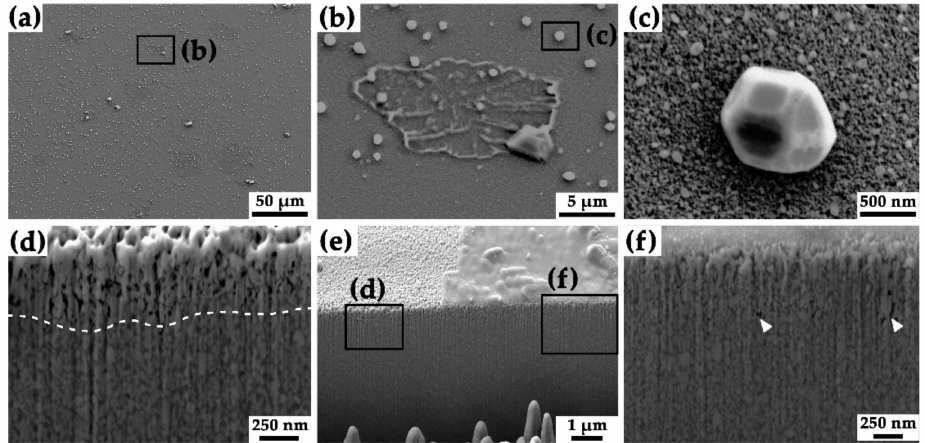
Figure 2. SE SEM images of a W/Cu composite annealed at 700 ◦ C: ( a ) overview of the polished surface, ( b ) representative Cu pool, ( c ) faceted Cu particle, ( d ) sub-surface region not covered by a Cu pool, ( e ) overview of the cross-section containing different areas and sub-surface structures and ( f ) sub-surface region below the Cu pool. In ( d , f ) the dotted line restricts the porous zone and white arrows indicate single pores,